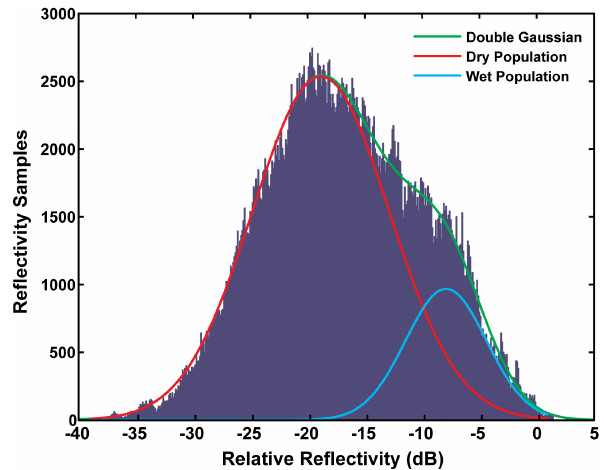
Fig. 3. Histogram of relative bed echo reflectivities in dB. The dis- tribution of 464000 points has a mean of − 15.9dB and FWHM of 19dB. It is well fit by a double Gaussian function with a population centered at − 18.8dB, FWHM 14.1dB and a more reflective popu- lation centered at − 11.8dB, FWHM 8.3dB. We identify echoes to the left as indicative of dry basal condition and those to the right as wet. Reflectivity values are scaled to a highly reflective subglacial lake that plots at 0dB in this